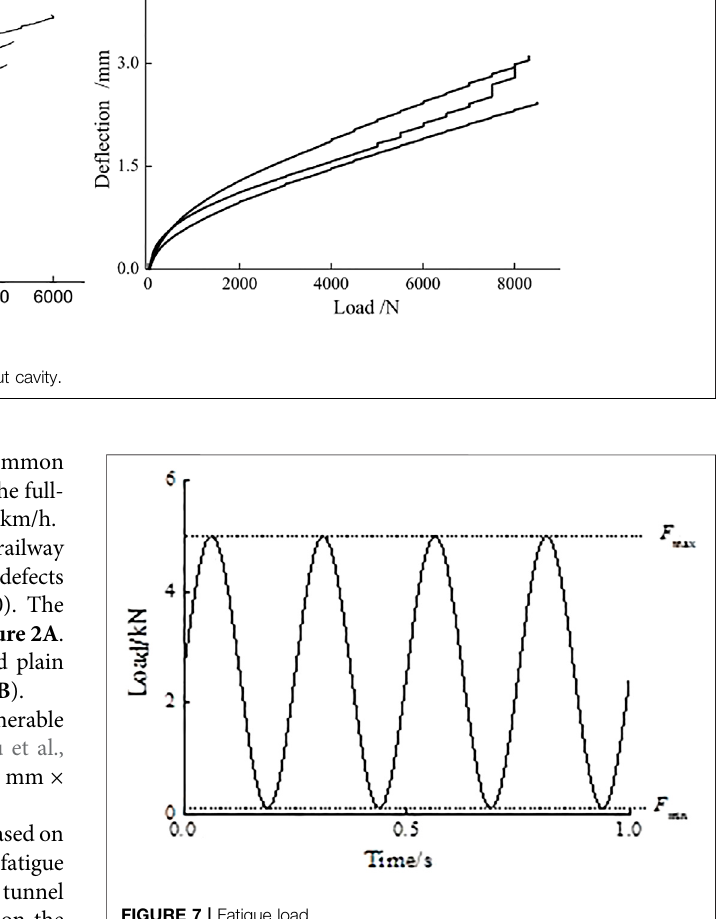
FIGURE 7 | Fatigue